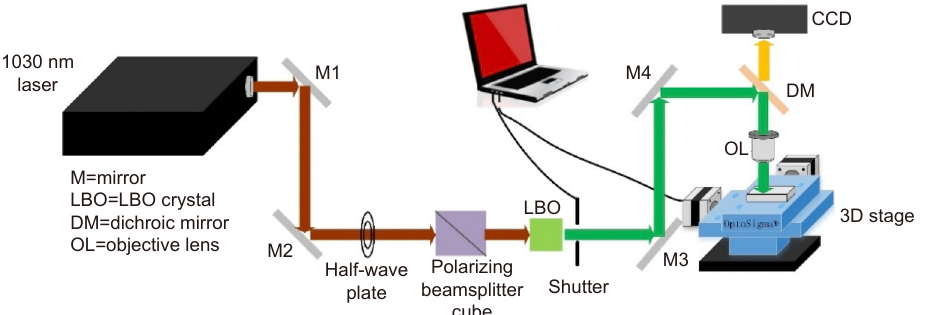
Fig. 1 | Schematic of laser fabrication system for microfluidic SERS chips. For generation of a second harmonic of 515 nm wavelength from 1030 nm and 233 fs laser, LBO was used. A half-wave plate and a polarizing beamsplitter cube are used to control laser energy. 3D precision motorized stage and an automatic shutter are controlled by the